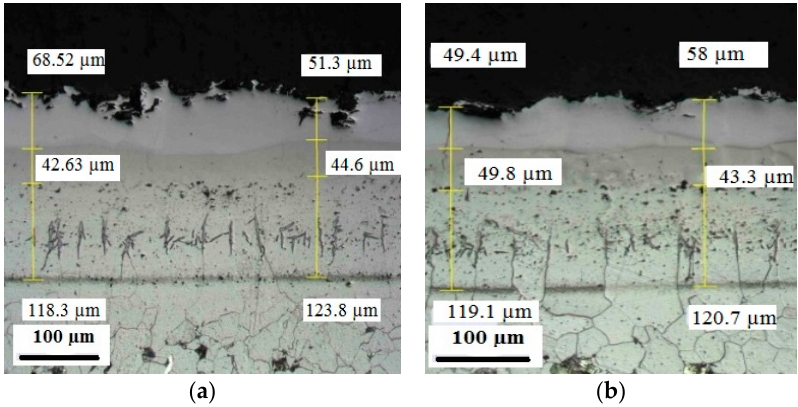
Figure A9. Microscopic images of the cross-section of CS-A-Z ( a ) before and ( b ) after the low-temperature corrosive attack after 168 h.